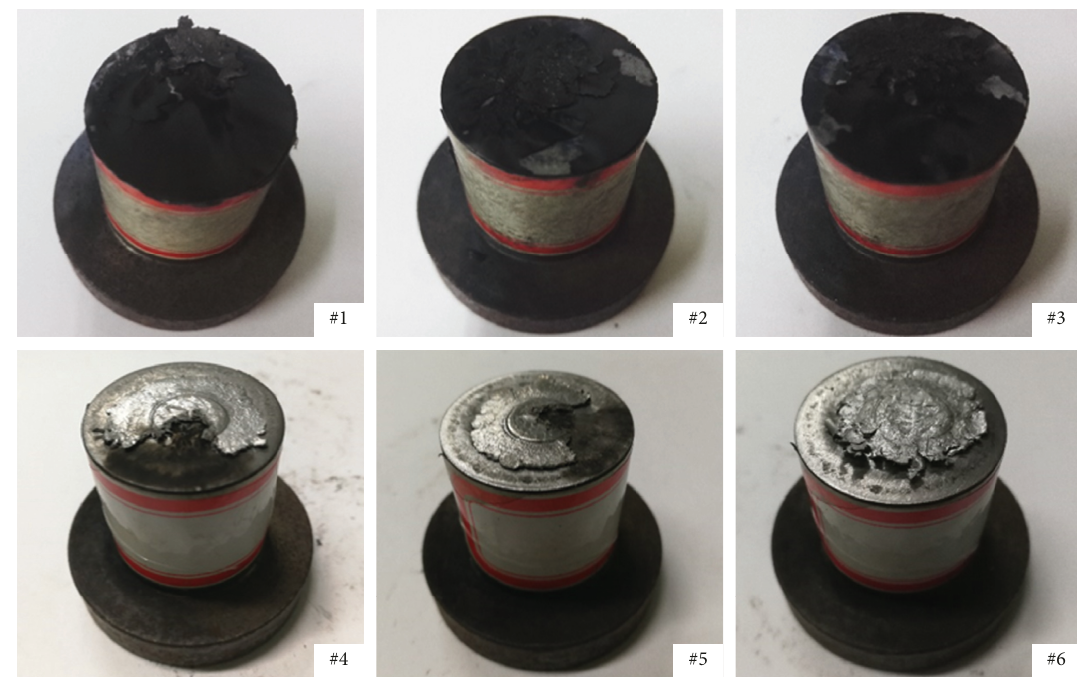
Figure 9: The states of specimens #1–#6 after drop hammer